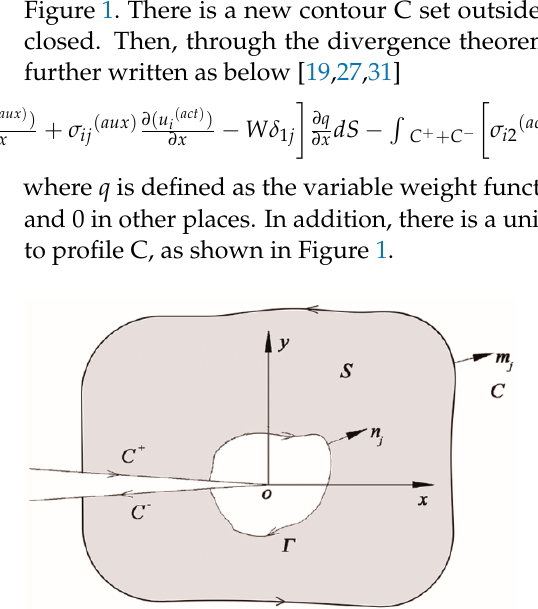
Figure 1. The equivalent surface integral of the interaction integral.